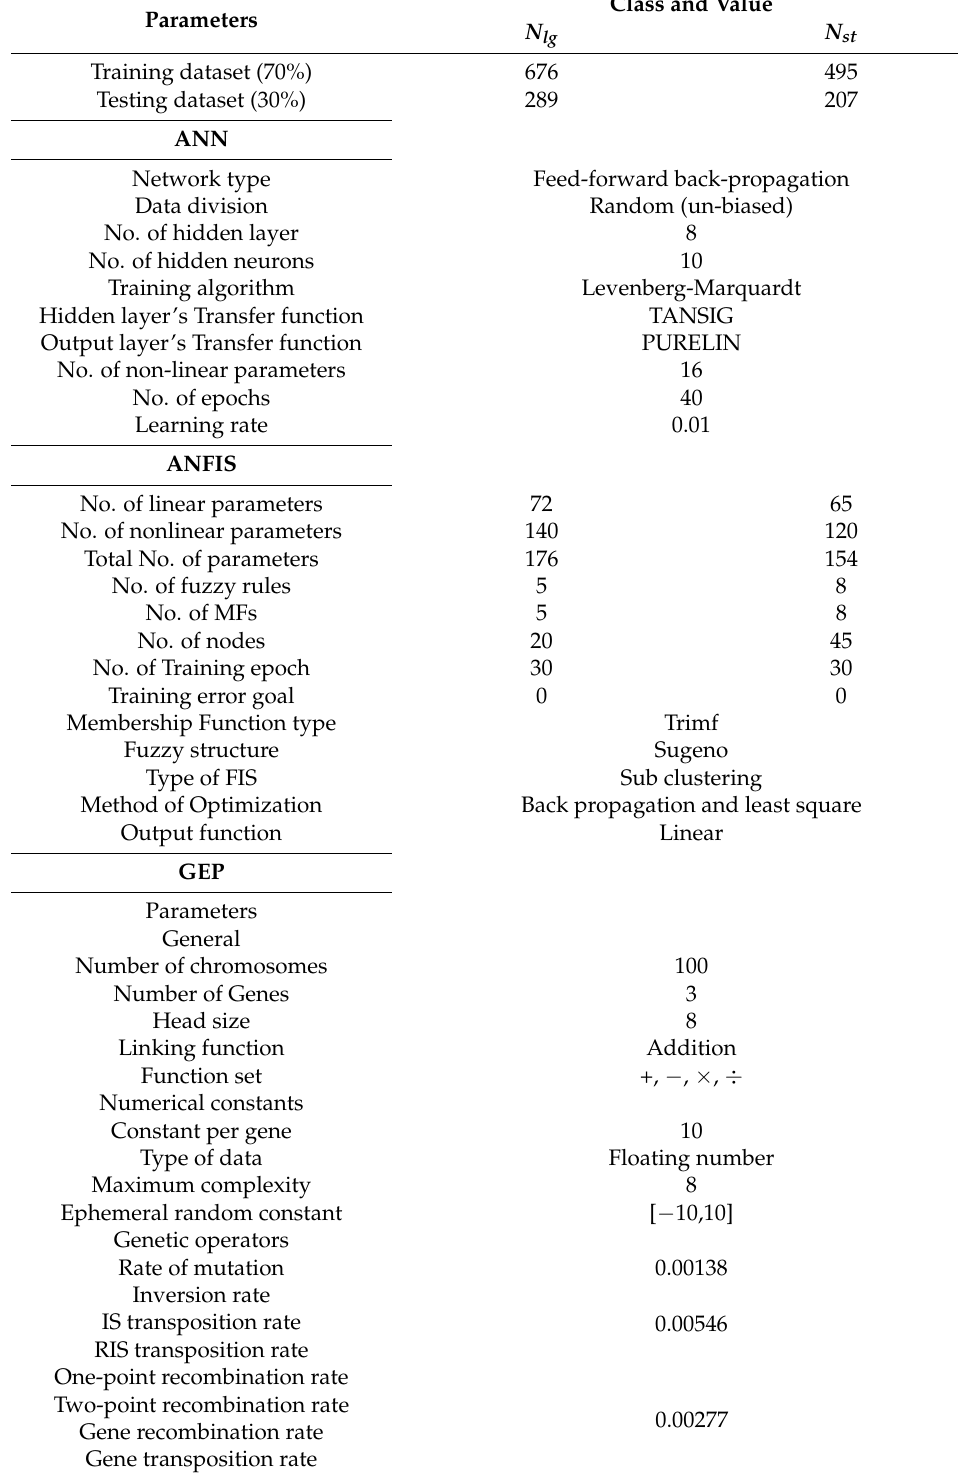
Table 2. The setting of different parameters of ANN, ANFIS, and GEP model used in current research.